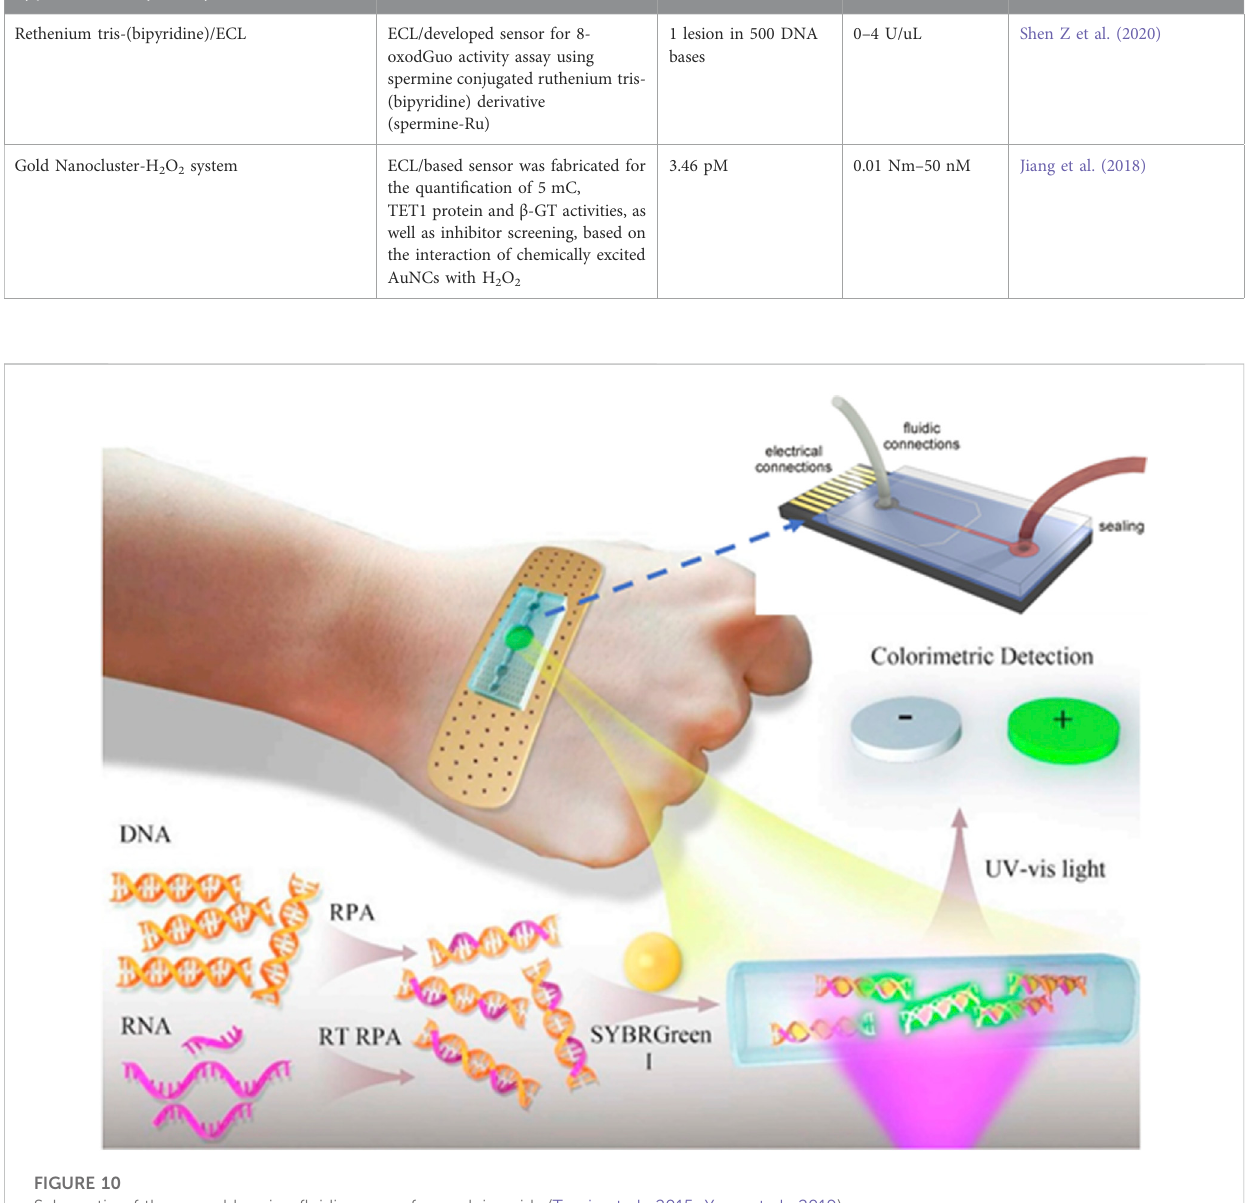
Schematic of the wearable micro fl uidic sensor for nucleic acids (Temiz et al., 2015; Yang et al.,